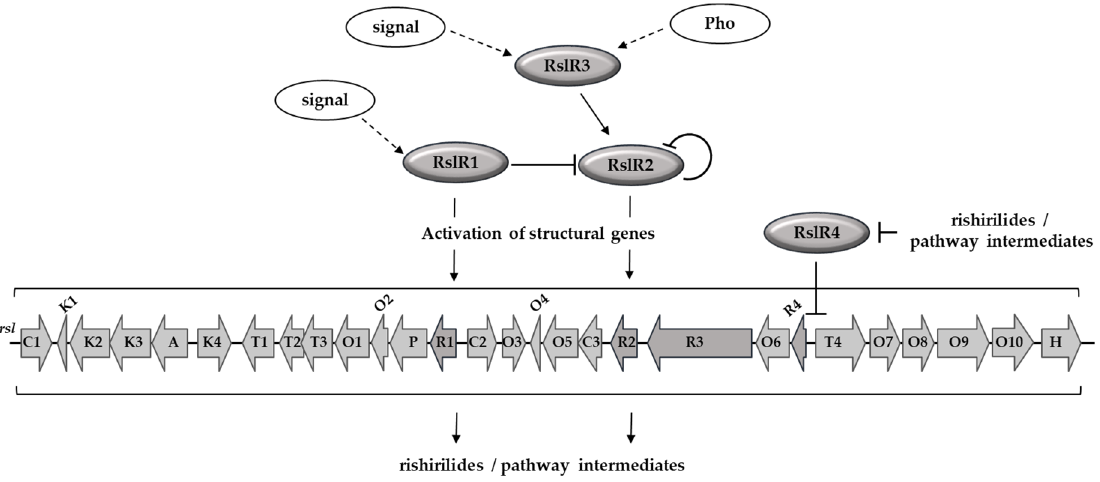
Figure 7. Proposed regulatory scheme of rishirilides biosynthesis.